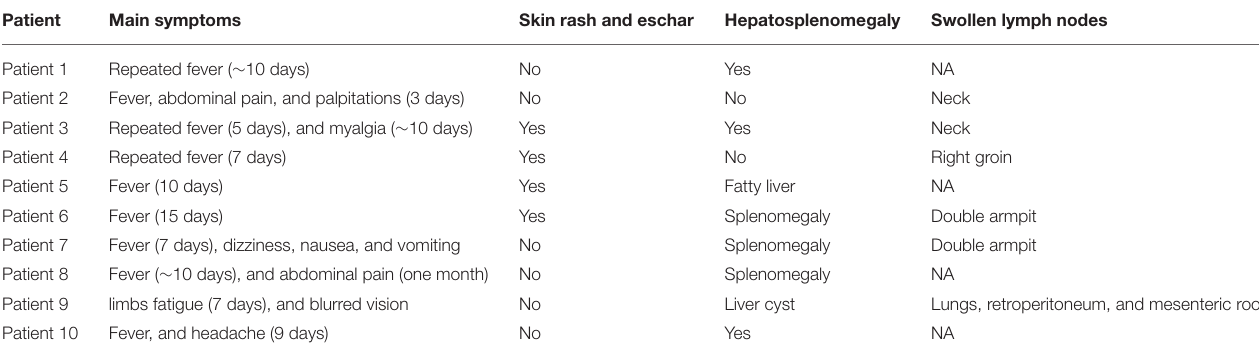
TABLE 1 | The clinical characteristics of the patients of this